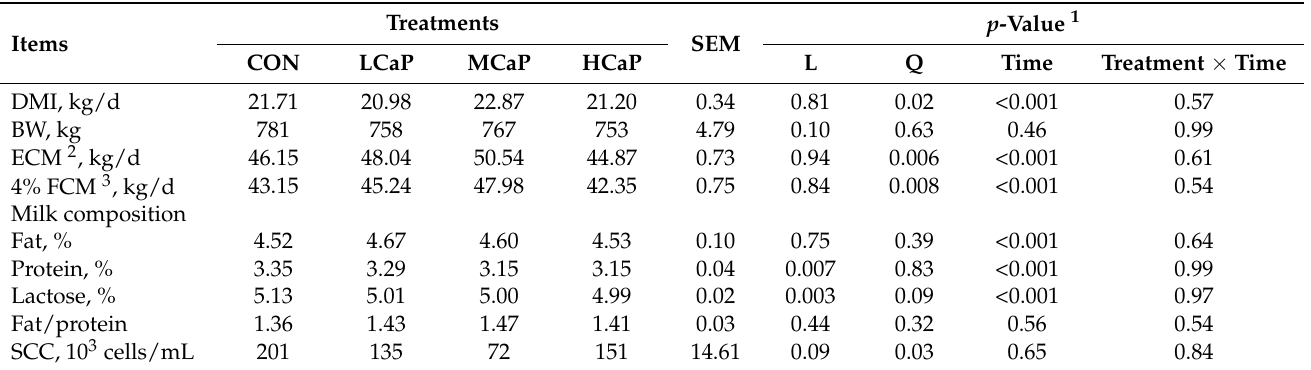
Table 1. Effects of supplementing calcium propionate on the production performance of dairy cows in early lactation.